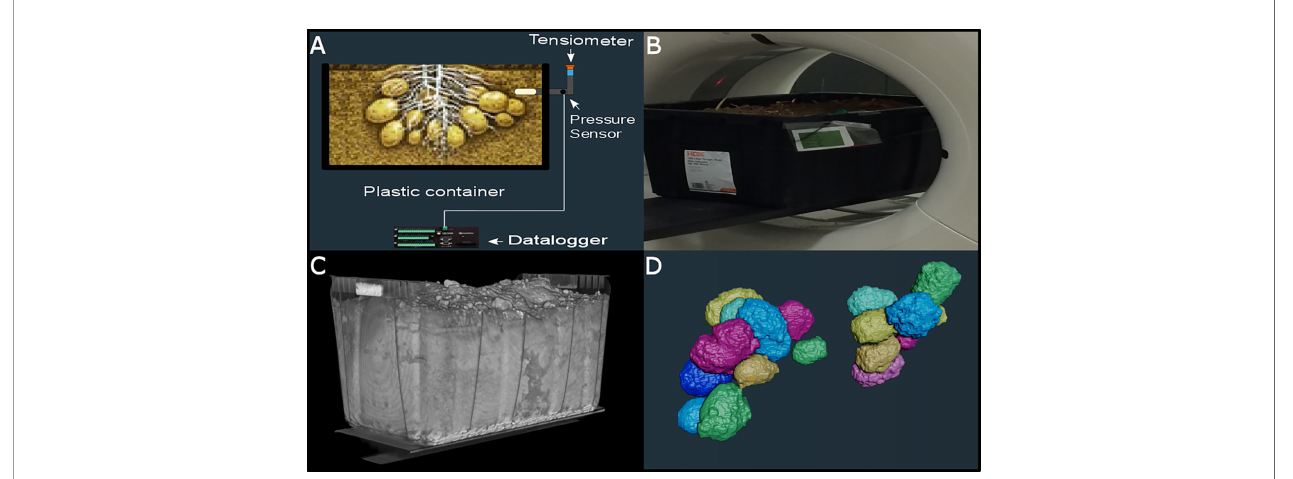
FIGURE 1 | (A) Scheme of the short side of an experimental unit with one tensiometer equipped with a pressure sensor inserted into the side and connected to a datalogger collecting data every two minutes. (B) CT scanning of an experimental unit. (C) 3D image reconstruction of a scanned experimental unit. (D) Top view of tubers after image processing and tuber identi fi